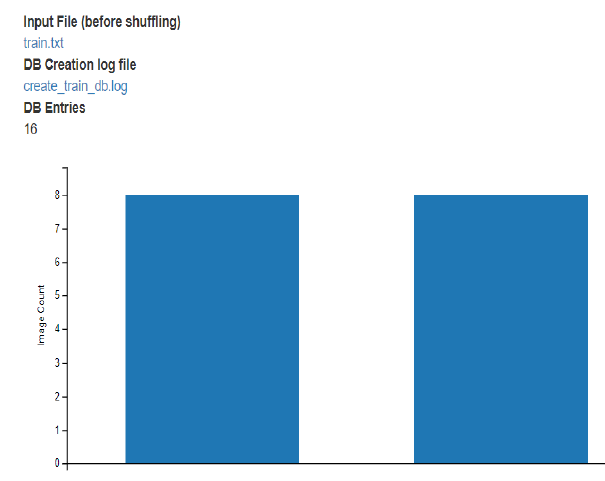
Figure 6. Creation of Image Count